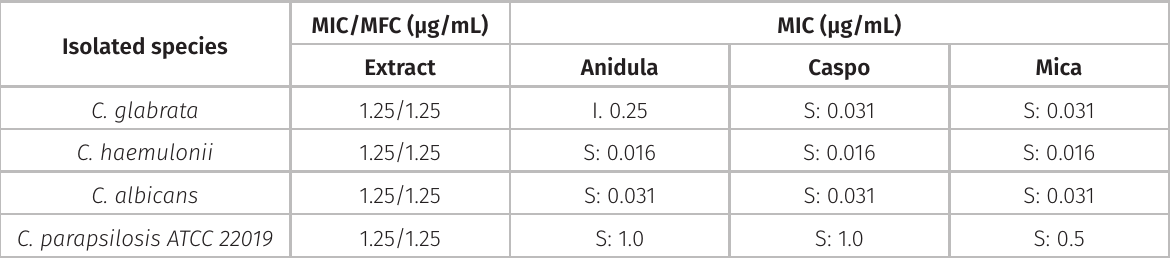
Table V. Antifungal activity of the dried extract of S. cumini measured by the minimal inhibitory concentration (MIC) and minimal fungicidal concentration (MFC).